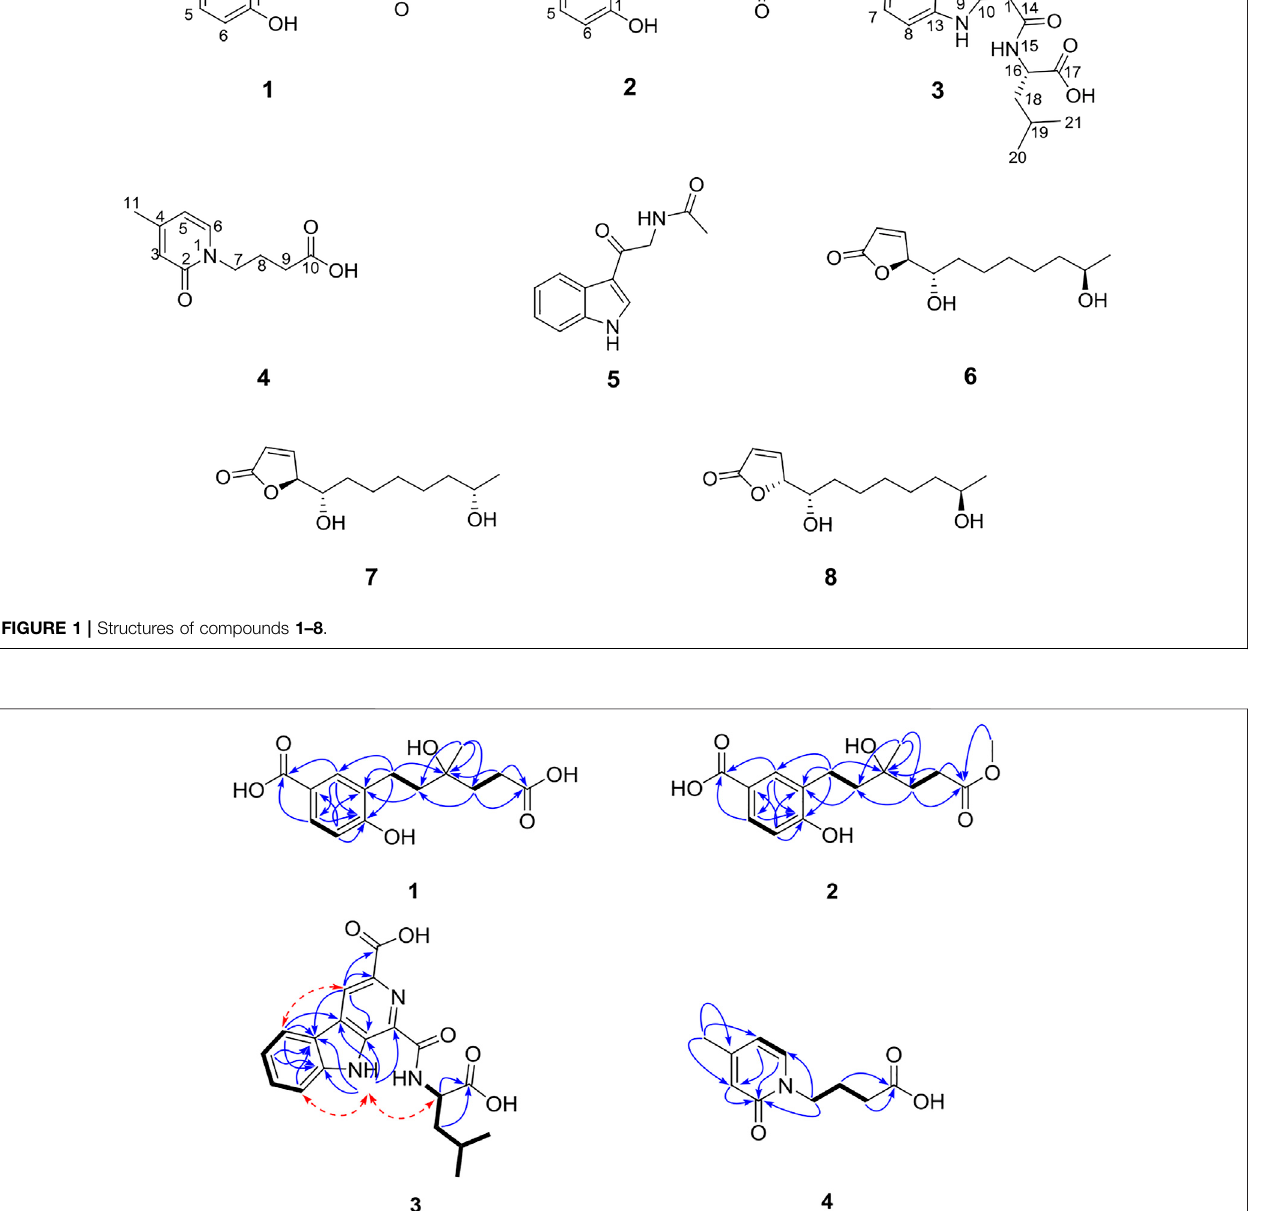
Frontiers in Chemistry |